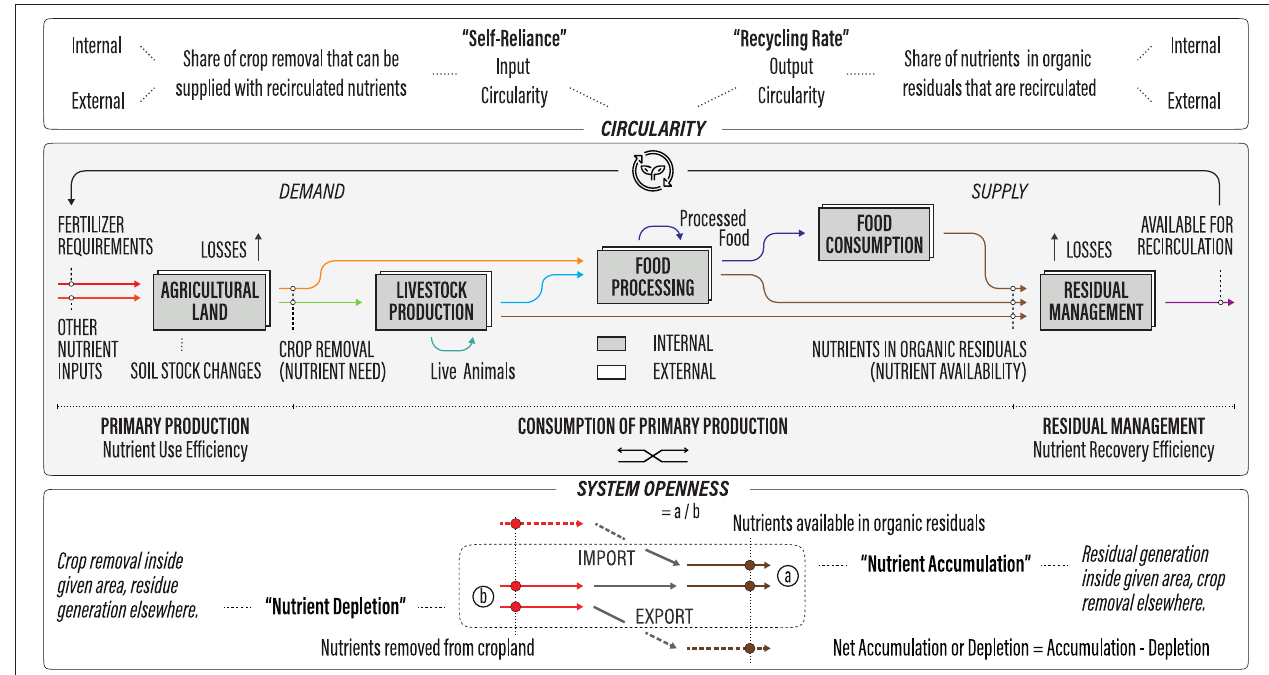
FIGURE 3 | Detailed analysis of the relationship between nutrient circularity and system openness. The middle part of the figure shows nutrient flows between the five subsystems. The top part of the figure distinguishes two notions of nutrient circularity, one focusing on outputs from residual management (recycling rate) and one on inputs to agricultural production (self-reliance). Both self-reliance and recycling rate can be estimated separately internal and external to the Okanagan. System openness is explained in the bottom part of the figure. The idea is that import of agricultural commodities leads to “nutrient accumulation” in the bioregion whereas the opposite holds true for export. System openness for a given nutrient element was defined as the proportion of this nutrient element in the harvest in the bioregion (b) that is available in organic residual in the bioregion (a). If a/b > 1, the bioregion benefits from nutrient inputs elsewhere. If a/b < 1, the opposite holds true. Figure adapted from Harder et al.